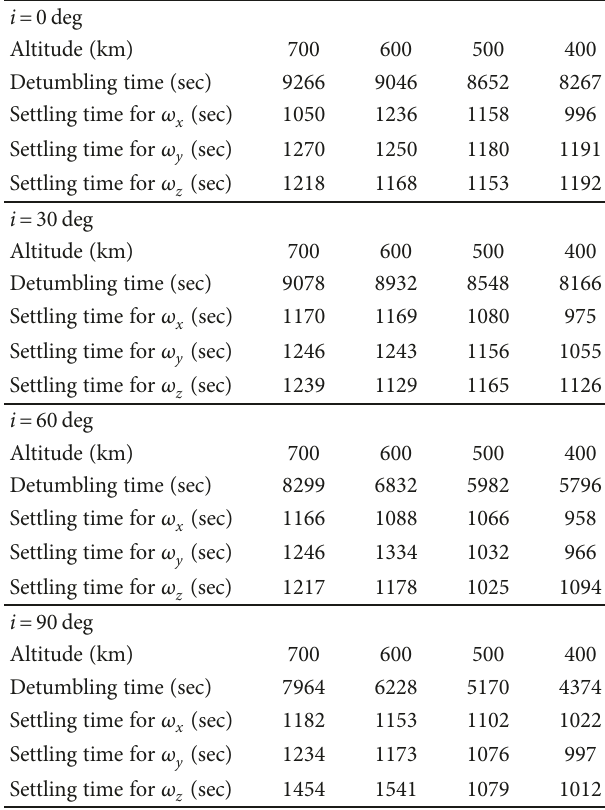
Table 4: Results from some selected test cases for ω =[10 10 10] deg/sec.